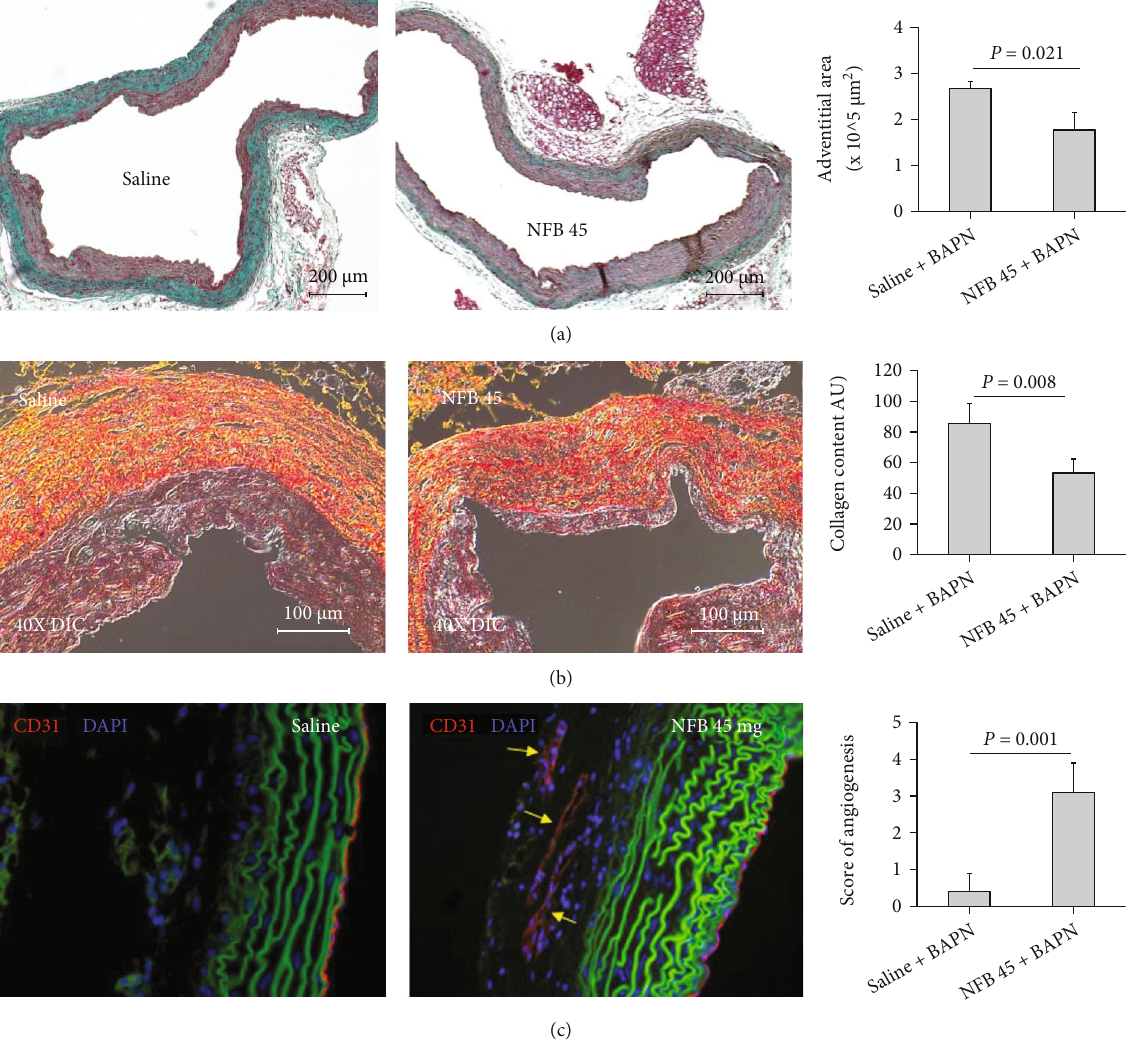
Figure 5: Chronic infusion of nicotine impairs TAAD adventitial fi brosis. (a) Masson ’ s staining of TAADs treated with saline or nicotine free base (NFB 45). Area of the dense adventitia (green) was calculated by integrating in vivo diameter of the TAADs. (b) Picrosirius Red staining of TAADs illuminated with polarized light (i.e., di ff erential interference contrast, DIC). Yellow and red substance represents collagens. The bar graph depicts collagen content in the adventitial layer of the TAADs. (c) IF labeling of CD31. Red: CD31+ structure; green: auto fl uorescence; blue: DAPI counterstain. Density of the microvessels in the adventitial layer was scored on a scale of 0 to 5. The bar graph shows scores assigned to the TAADs, with a larger score corresponding to a higher density. Data were analyzed using unpaired Student ’ s t -test ( n = 5 ‐ 7 per